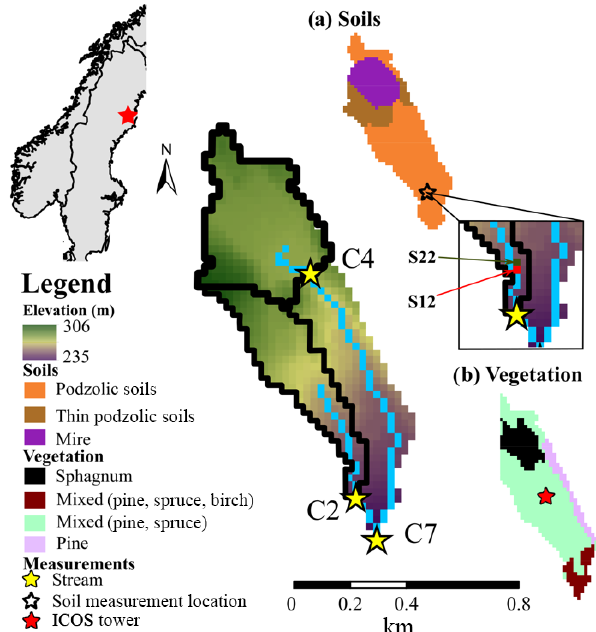
Figure 1. Location of the Svartberget within Sweden and its ele- vation profile with the channels and stream measurement locations (yellow). Inset figures show (a) catchment soils with the locations of S12 and S22, and (b) catchment